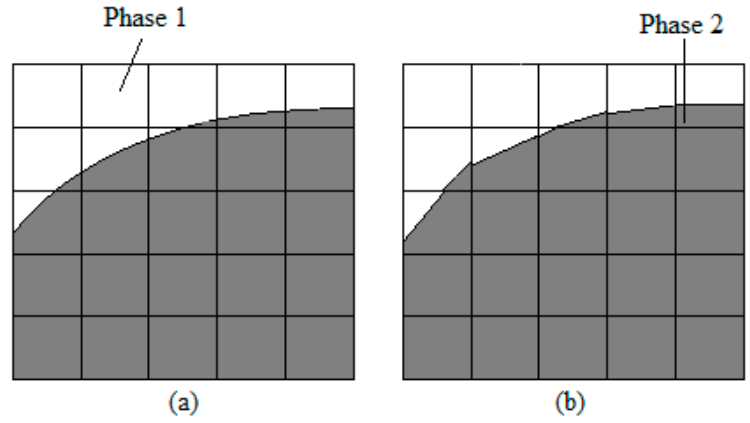
Figure 2. ( a ) Real Interface Boundary; ( b ) Linear Interface Reconstructed Within Each Cell Using PLIC, Following [31].